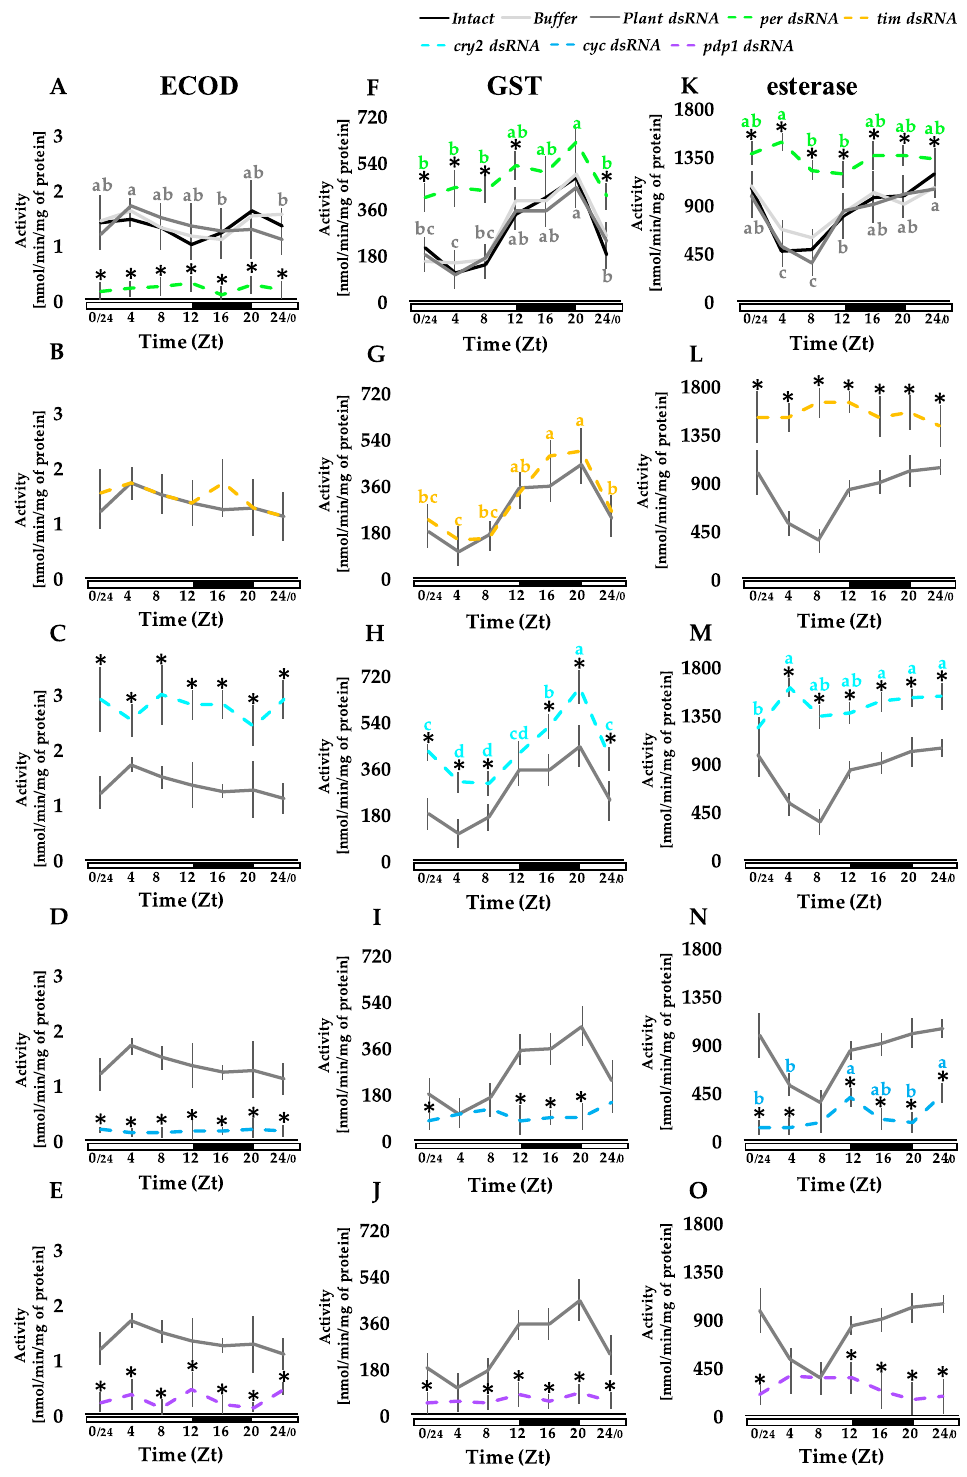
Figure 3. Changes of the daily patterns in the activity of xenobiotic metabolizing enzymes in the midgut caused by RNAi-mediated disruption of clock gene expression. The activities of ECOD ( A – E ), GST ( F – J ), and esterase ( K – O ) were analyzed in the fat body of the larvae whose molecular oscillator was altered by injection of clock gene dsRNA (as in experiments whose results were presented in Figure 2). Statistical analyses of the obtained data and the results presentation on the graphs are analogous to those described in Figure